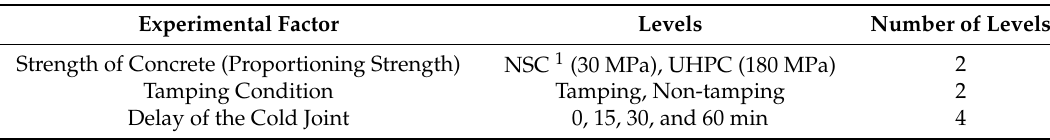
Table 1. Experimental factors and